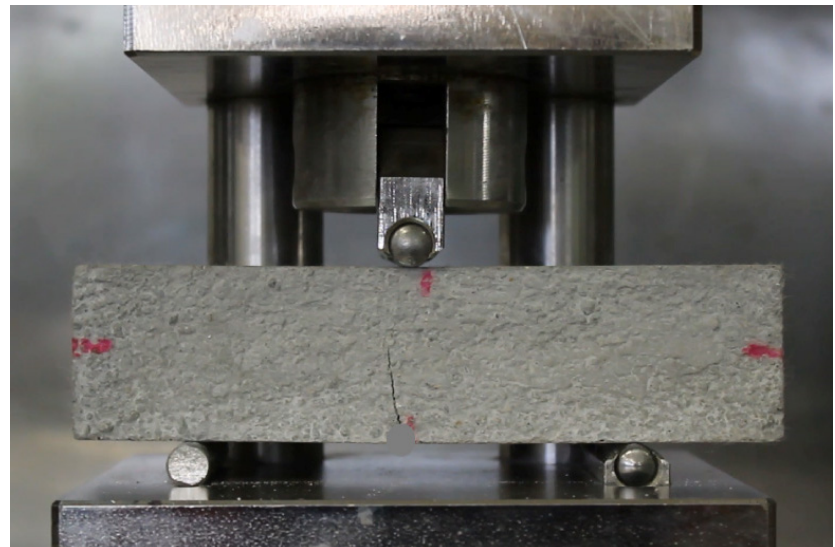
Figure 1. Specimen notched in the middle of its length and pre-cracked, at 28 days from their production.